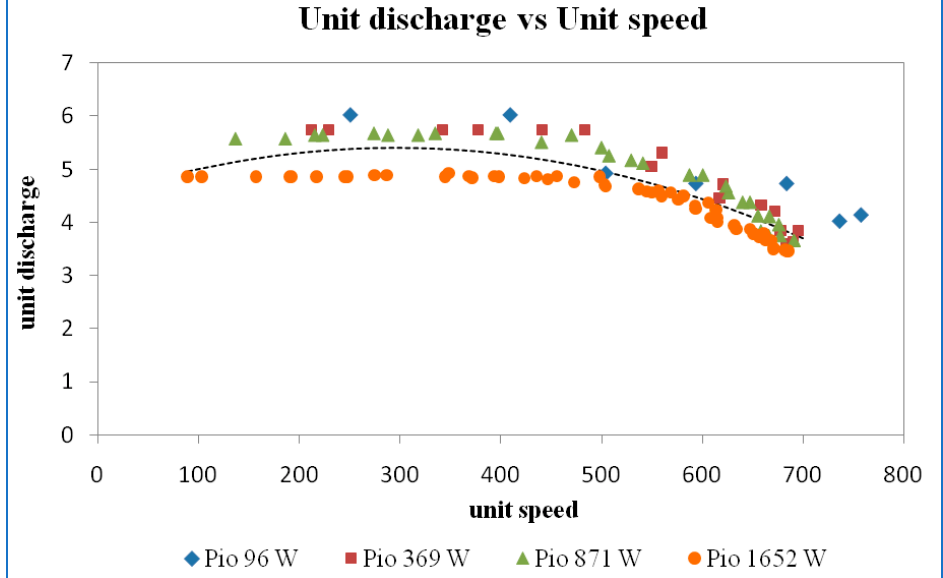
Figure 34. Unit discharge vs. unit speed at a guide vane opening of 19 mm. The variation in unit output power versus unit speed operating at different power inputs is shown in Figure 35. The maximum output power is found at a unit speed of 400 rpm, the same as that at a GVO of 10 mm, 13 mm, and 19 mm.